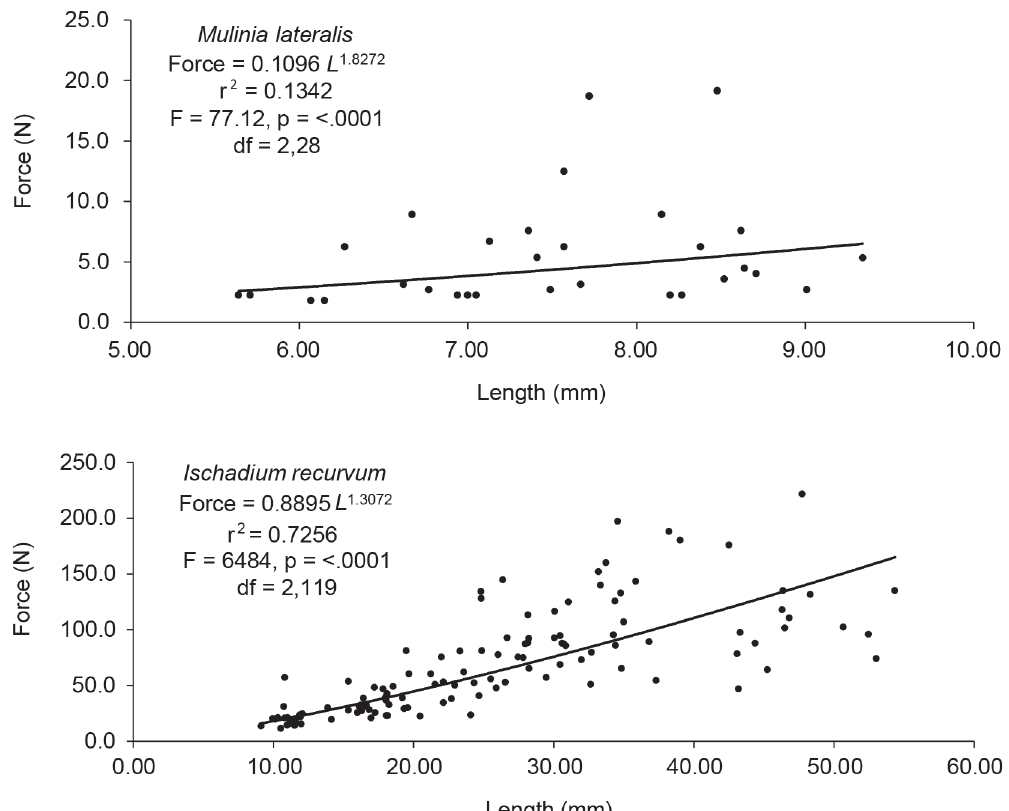
Fig 6. Shell strength relative to length of Ischadium recurvum and Mulinia lateralis . Shell strength, measured as the amount of force (N) needed to crack the shell, as a function of length (mm) for Ischadium recurvum and Mulinia lateralis , two common prey items consumed by wintering surf scoters on the Chesapeake